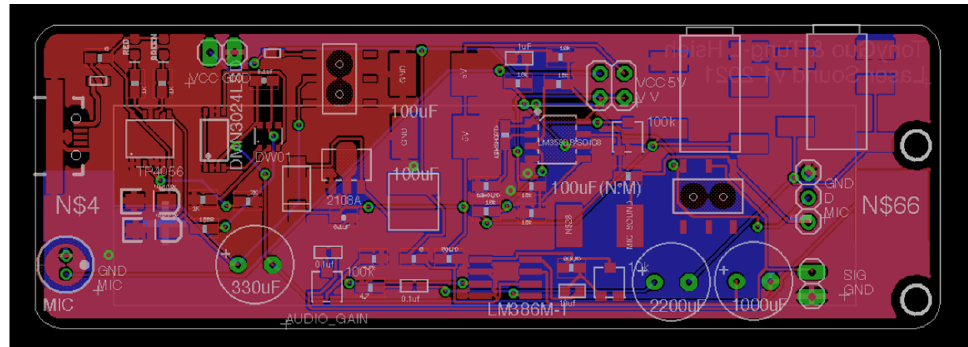
Figure 3. The PCB layout of the laser transmission device.